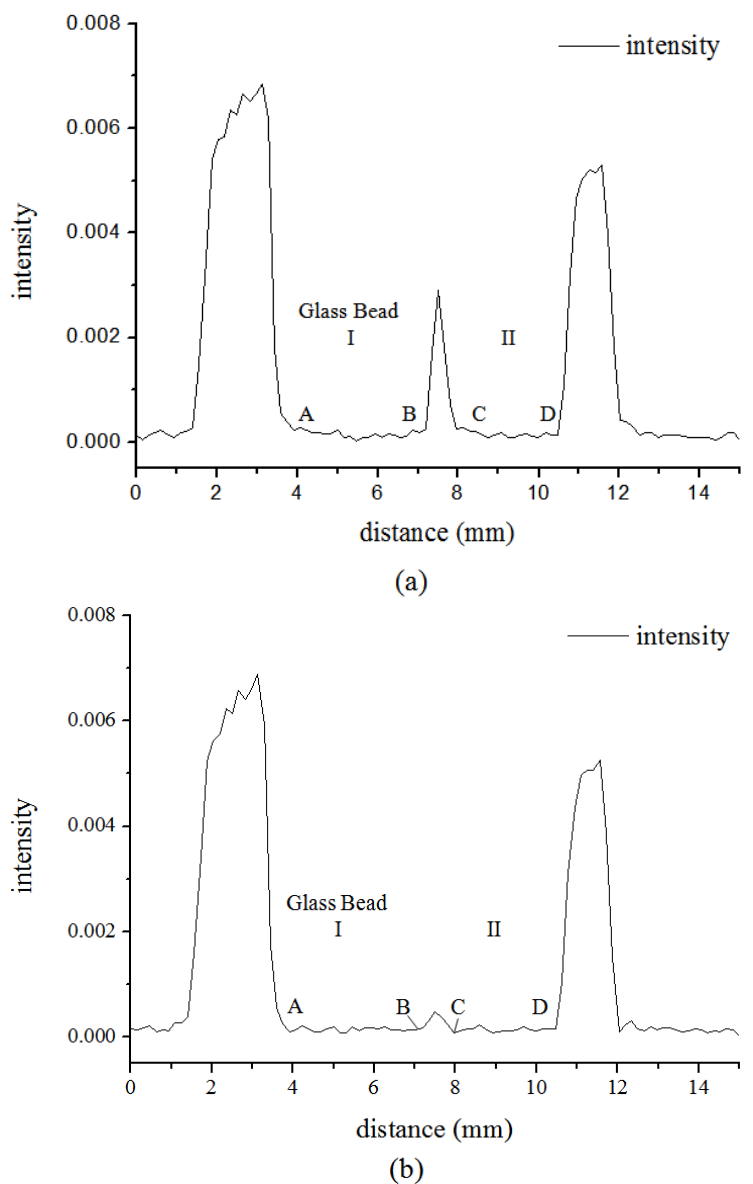
Figure 5. The images of the MRI signal intensity along the line in Figure 4. ( a ) At 10 min; ( b ) At 65